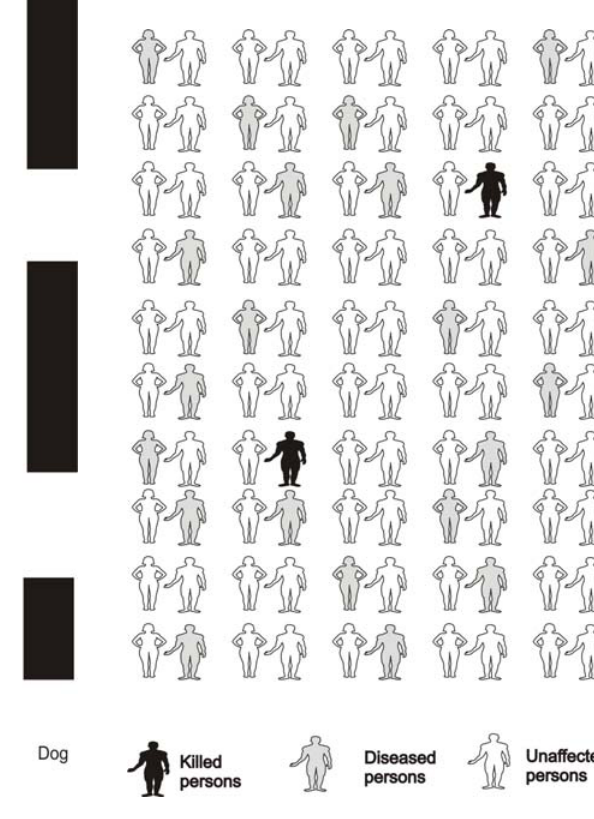
FIGURE 4 . The Spanish influenza H1N1 pandemic (1918–1919) annihilated nearly 2% of the worldwide population at the